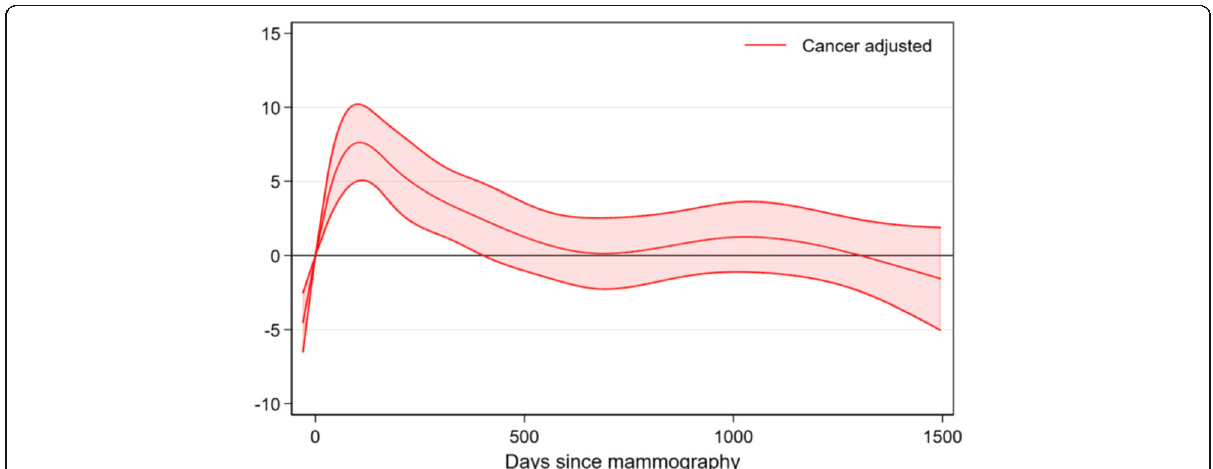
Fig. 6 Course of fatigue related to fatigue level before mammography for women with breast